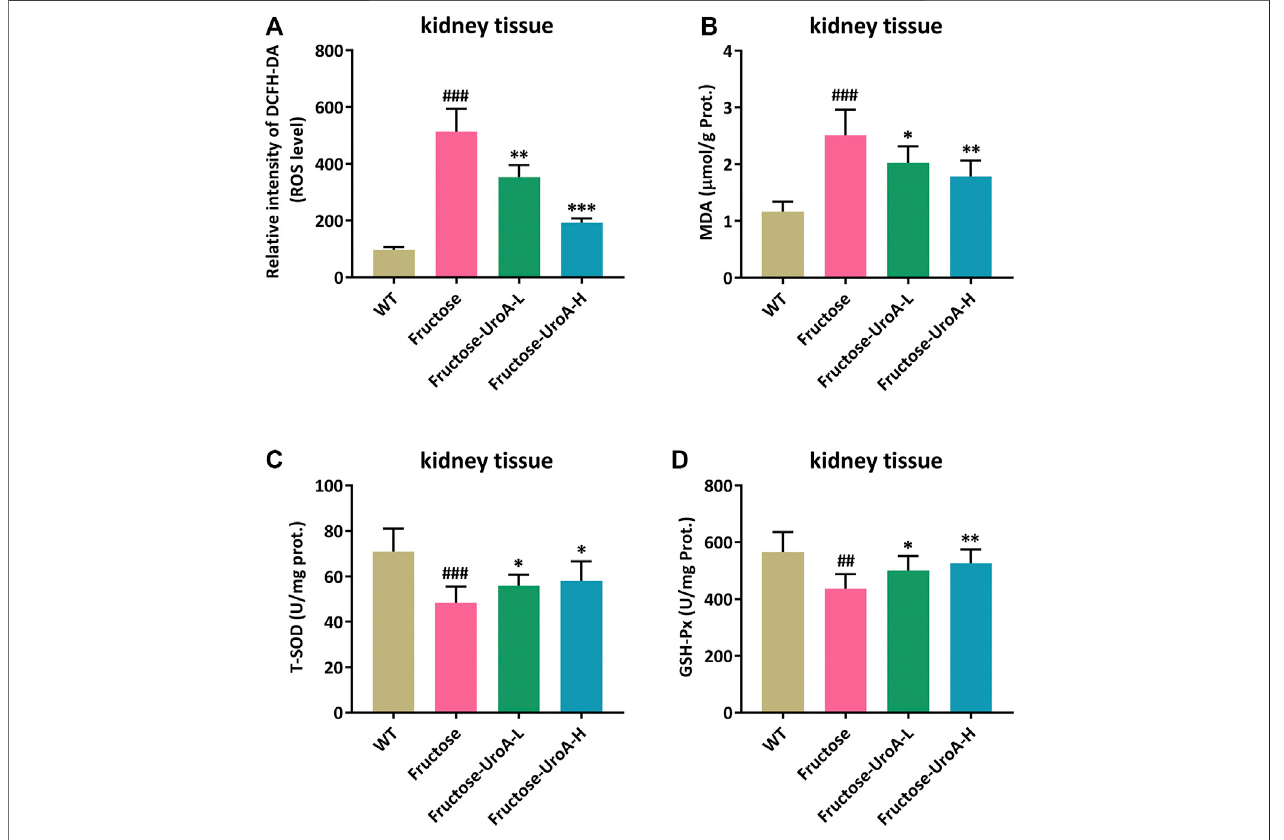
FIGURE 2 | Urolithin A (UroA) attenuates renal oxidative stress in fructose-induced urate nephropathic mice. (A) ROS level in renal tissues measured by 2 ′ , 7 ′ - Dichlorodihydro fl uoresceindiacetate (DCFH-DA)staining. (B – D) MDAcontentand T-SOD/GSH-Px antioxidantenzymeactivity inkidneytissues fromthewild-type(WT) or fructose-fed mice with intragastric administration of either vehicle or UroA, respectively. Mean ± S.D., n = 8. ## p < 0.01, ### p < 0.001 versus the WT group; * p < 0.05, ** p < 0.01, *** p < 0.001 versus the fructose group. UroA-L and UroA-H represent intragastric administration of urolithin A at low (50 mg/kg/day) and high (100 mg/kg/day) doses, respectively. Prot. is the abbreviation of